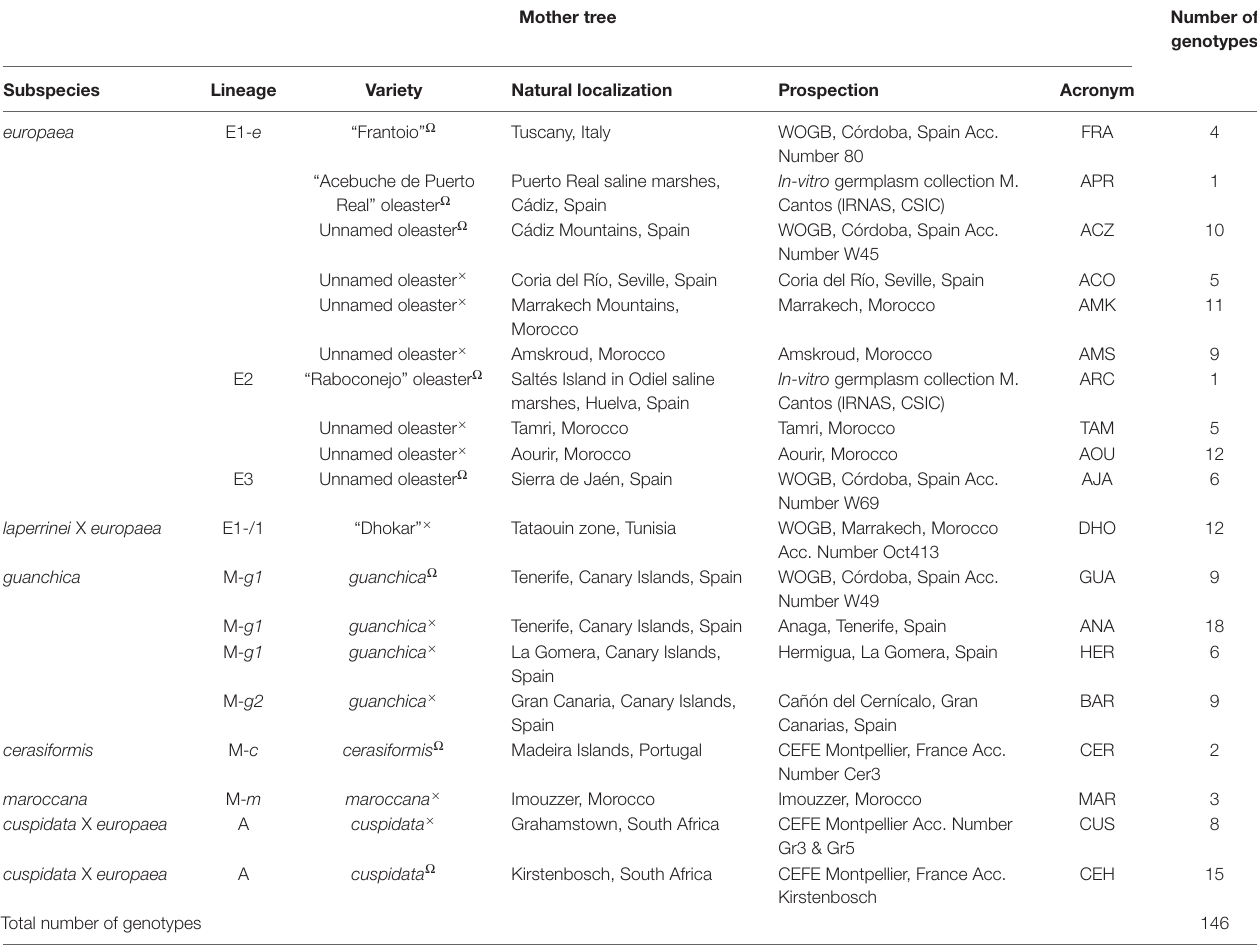
TABLE 1 | Origin and code of the 146 olive genotypes of the SILVOLIVE